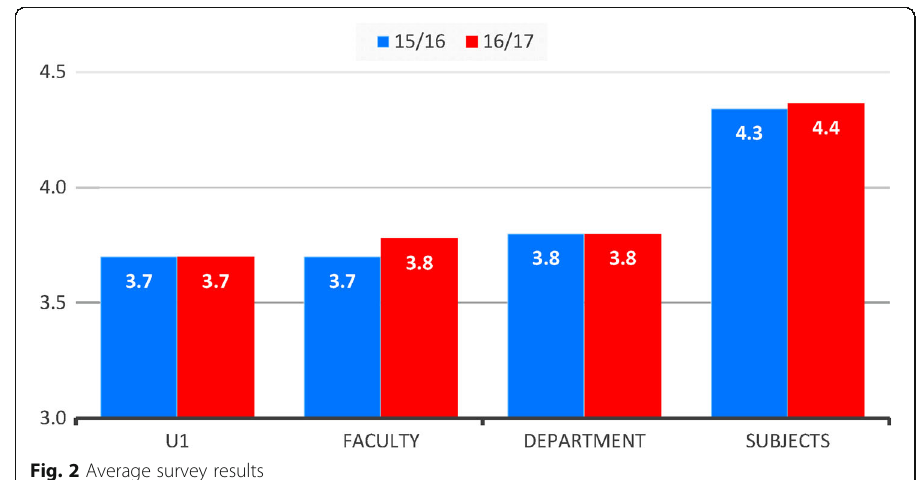
Fig. 2 Average survey